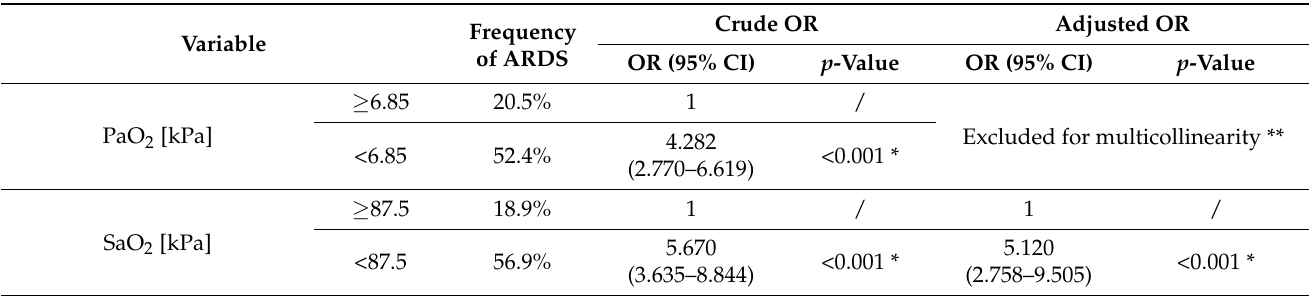
Table 4. Crude and adjusted OR for variables available upon hospital admission with regard to predicting ARDS development of hospitalized COVID-19